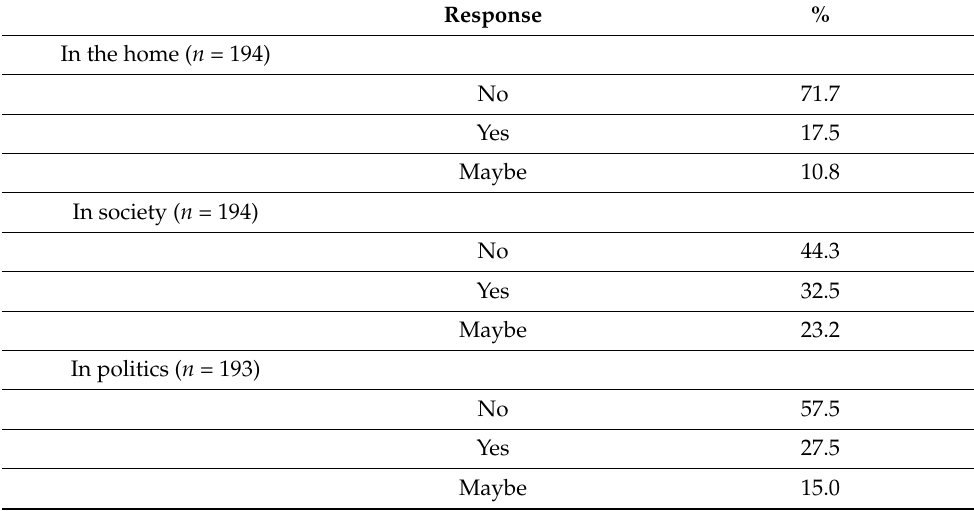
Table 4. Have women’s rights gone too far? Younger